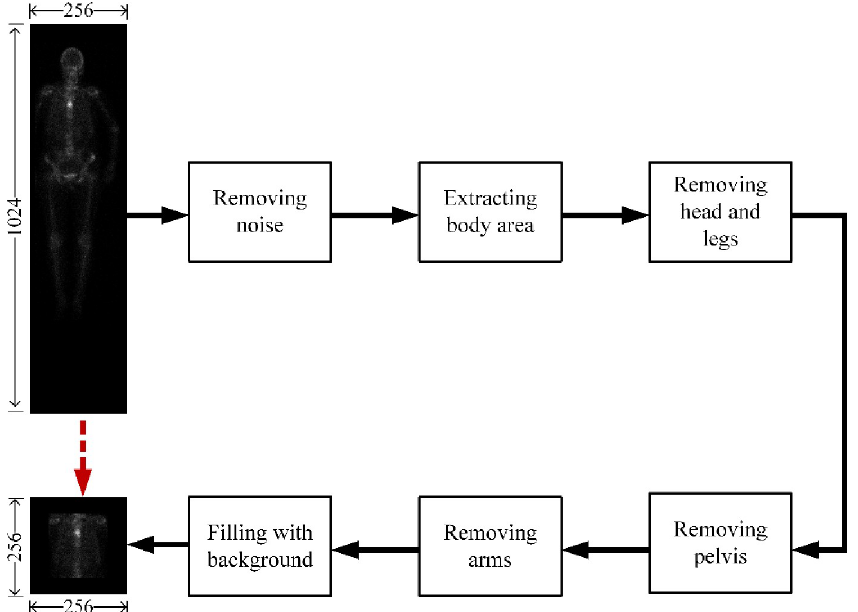
Fig 1. The process of cropping a 256 × 256 thorax bone SPECT image from the original 256 × 1024 whole-body bone SPECT image.